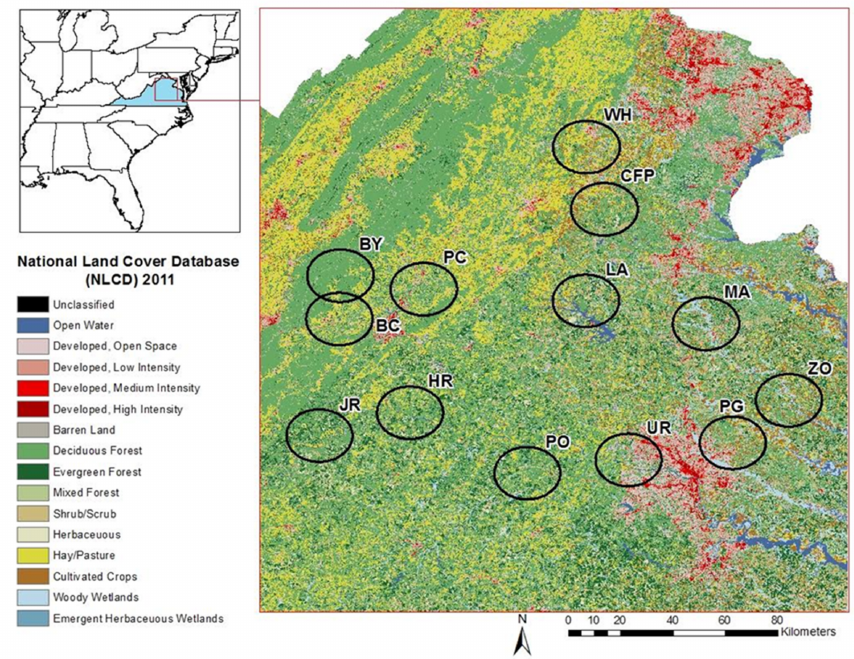
Figure 2. Sampling sites surrounded by 10 km diameter buffers (black circles) and superimposed on 2011 NLCD imagery with condensed land cover categories indicated at left. BC: Beaver Creek